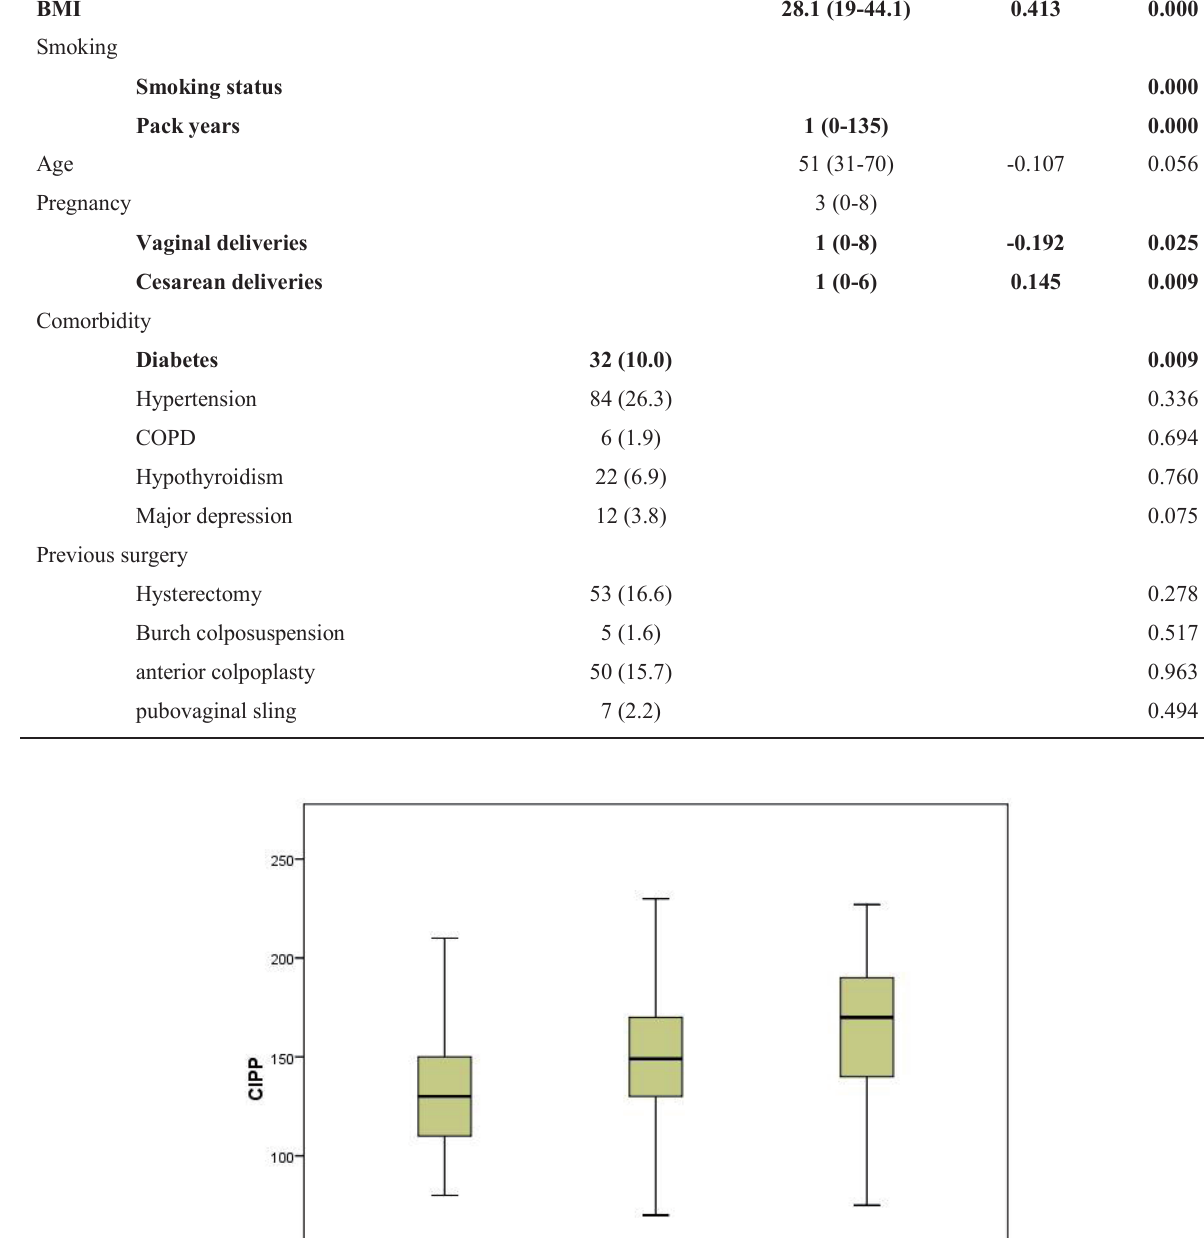
Table 1 - Clinical factors related to CIPP on univariate analysis.